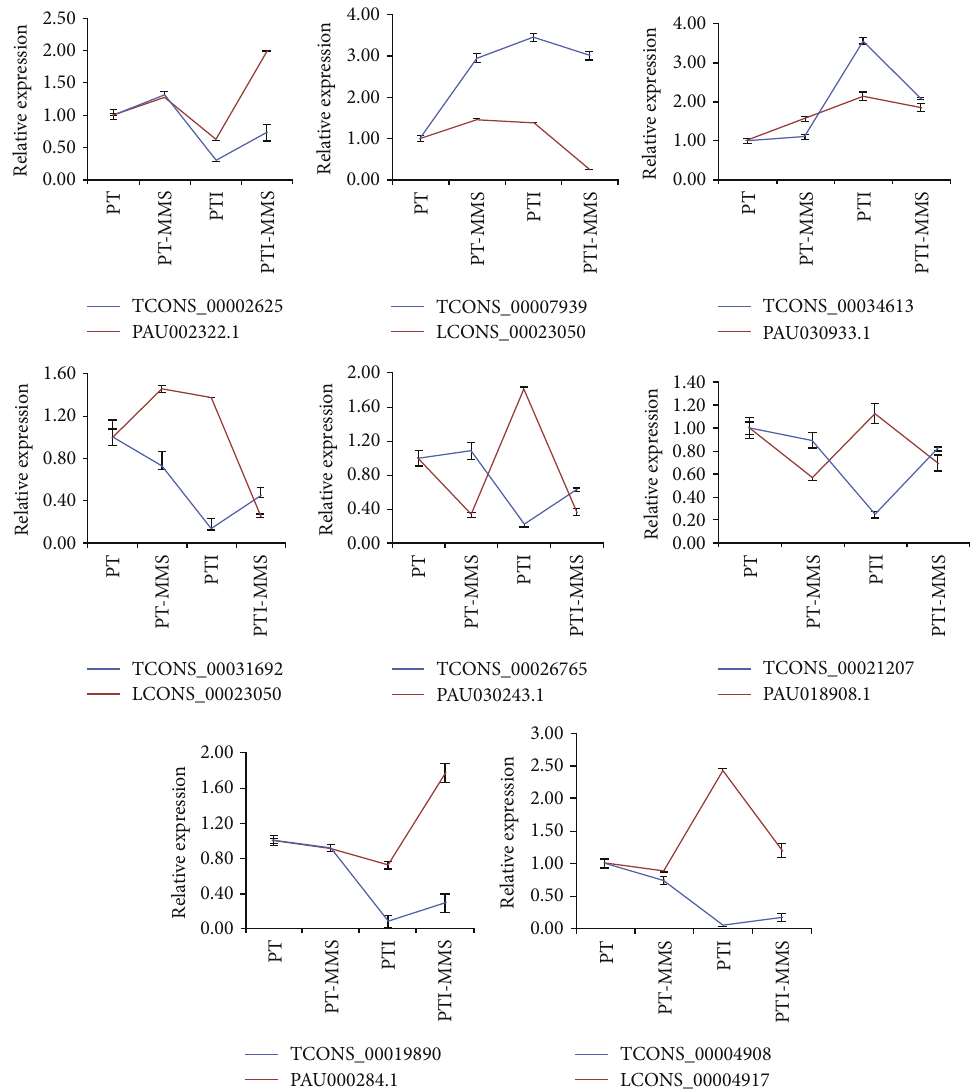
Figure 6: Relative expression of the target genes of eight P. tomentosa